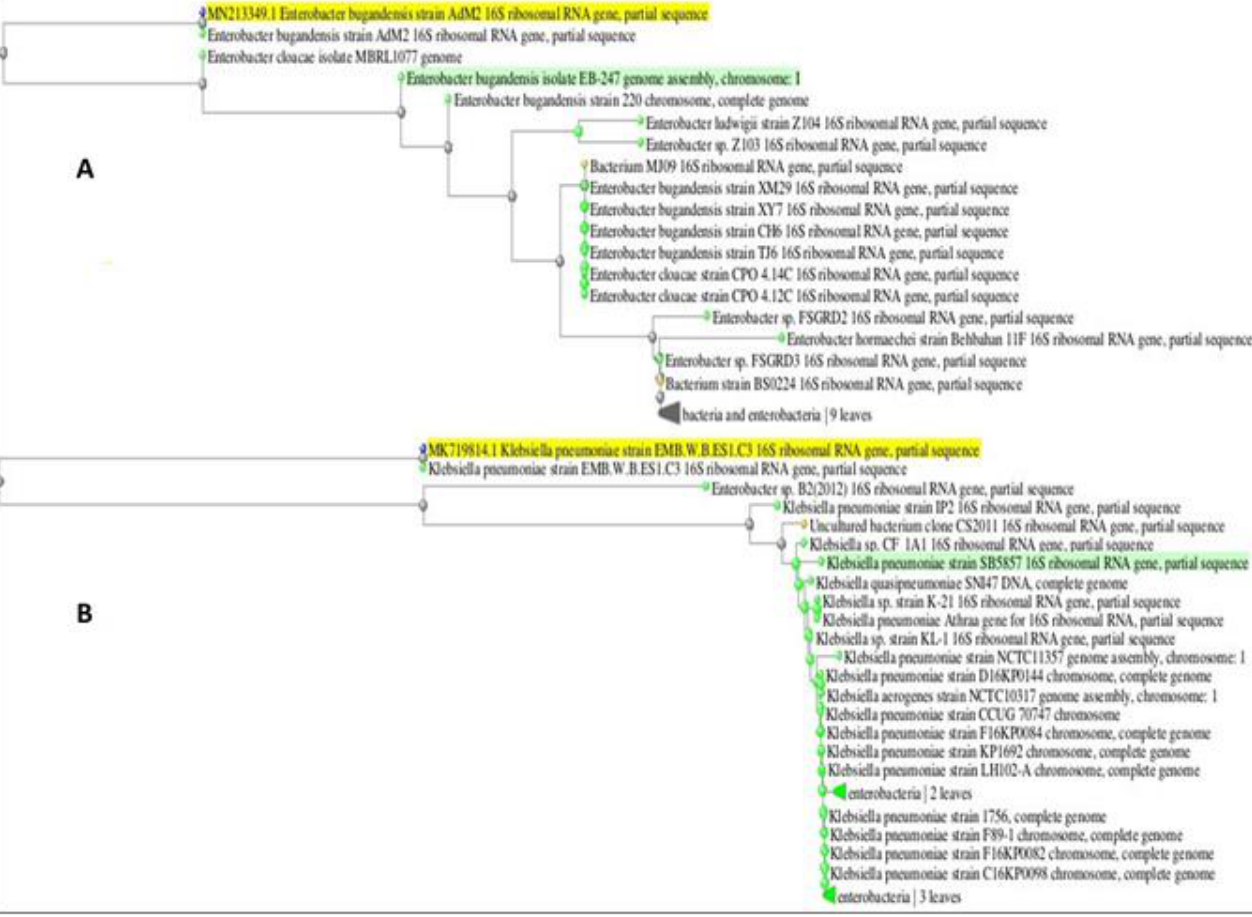
Figure 3: Phylogenetic trees of Enterobacter bugandensis (A) and Klebsiella pneumoniae (B) isolates from normal cattle flora compared to similar 16SrRNA gene